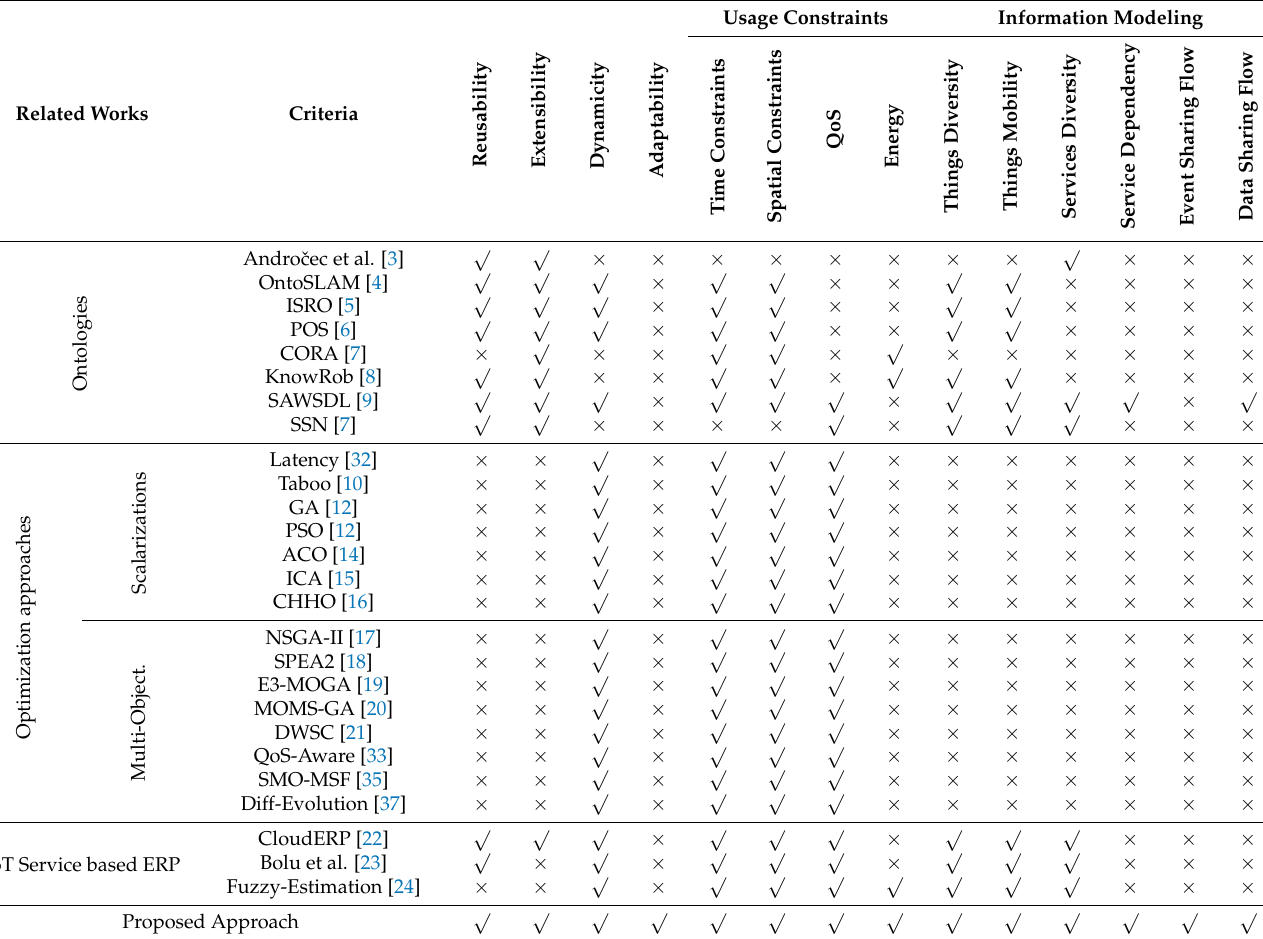
Table 1. Review of existing ontologies, service composition, and IoT Cloud